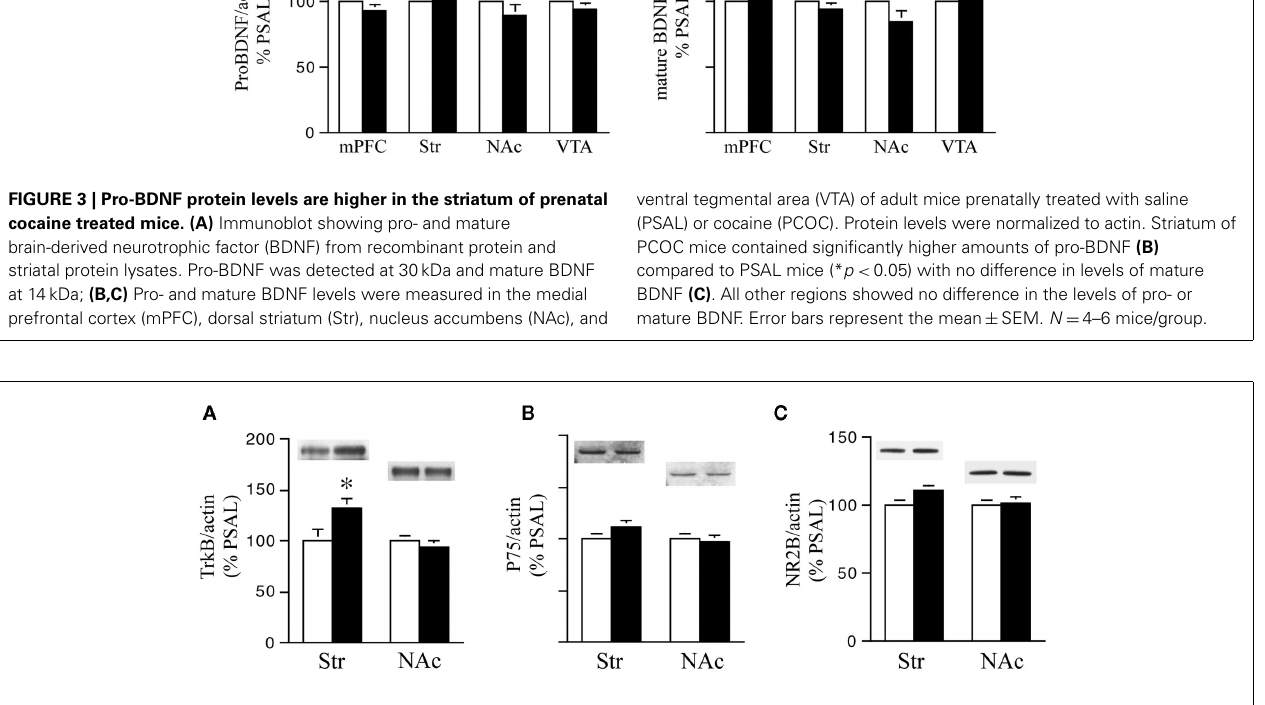
FIGURE 4 |TrkB receptor protein levels are higher in the striatum of prenatal cocaine (PCOC) treated mice. Total protein levels of (A) tyrosine kinase B (TrkB), (B) p75 receptors and (C) NR2B receptor subunits were analyzed in the dorsal striatum (Str) and nucleus accumbens (NAc) of prenatal saline (PSAL) treated vs. PCOC treated adult mice. (A) TrkB receptor levels